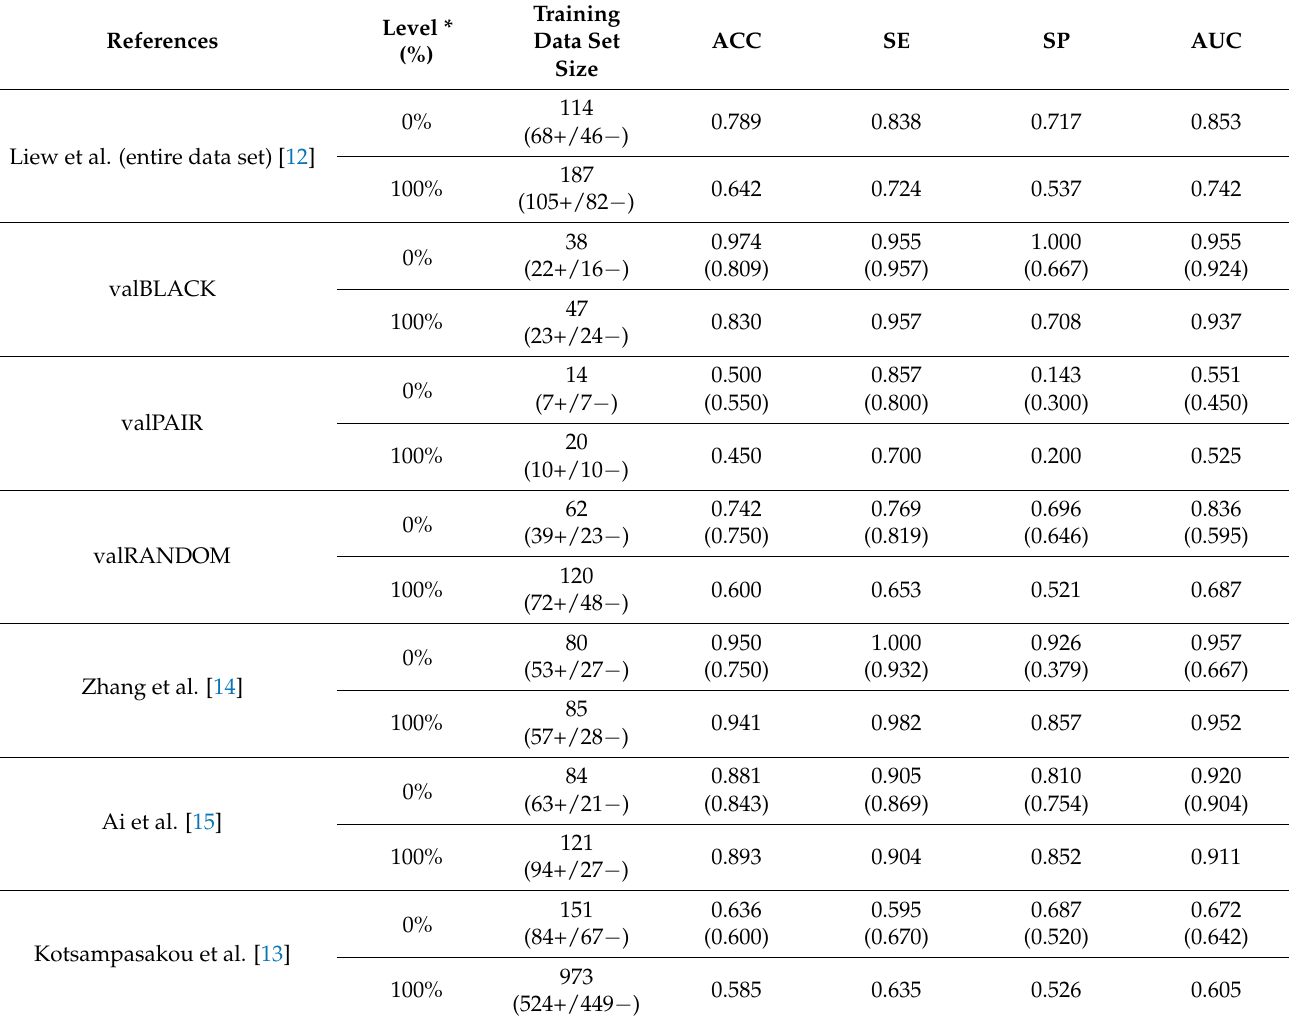
Table 5. Performance comparison of the DNN-based model with external data